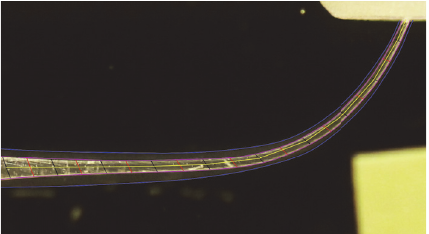
Figure 2: Arcs were obtained from the existing concentric circles (red lines) and from the additional ones (black lines); we also obtained the mean point of the chords subtended by each arch. A segmented straight line (yellow line), representing the mean preinstrumentedaxis,wasthereforeobtainedjoiningtogetherallthe median points of the